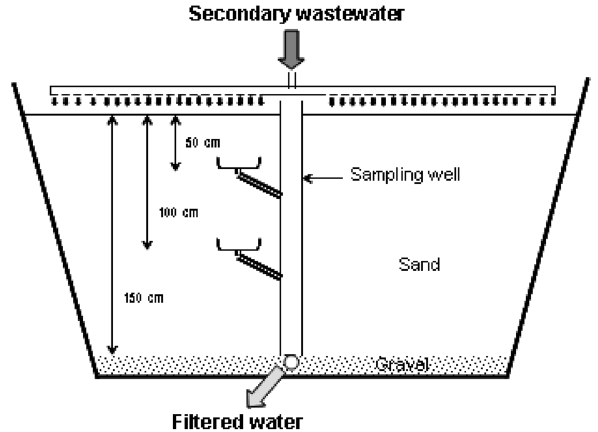
Fig. 1 Schematic drawing of the sand filter ( not to scale